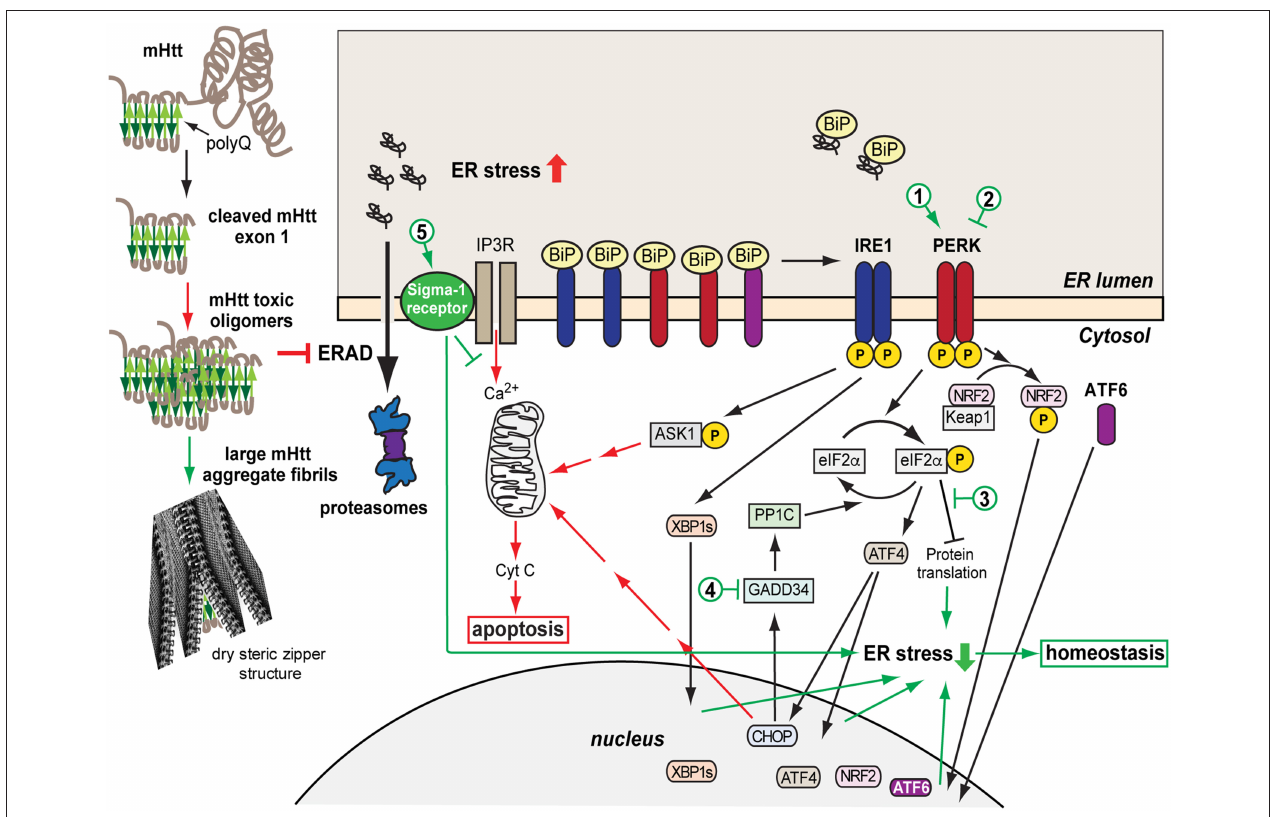
FIGURE 1 | Model of mHtt aggregation, generation of ER stress and the consequent UPR protective and later pro-apoptotic responses. A misfolded mHtt monomer, with the aggregation prone polyQ domain indicated (beta sheets in green) is cleaved and associates with other monomers to form toxic oligomers, which among other effects cause sequestration and depletion of ERAD factors such as p97, inhibiting ERAD. mHtt oligomers can associate into larger aggregate fibrils with dry steric zipper structure that shield the toxicity of mHtt. However, the transient presence of toxic mHtt oligomers, inhibiting ERAD, causes accumulation of unfolded secretory proteins and ER stress, activating the UPR sensors IRE1, PERK, and ATF6, starting an initial protective or adaptive phase of the UPR. This includes upregulation and translocation to the nucleus of transcription factors, XBP1s, ATF4, NRF2, ATF6, which induce expression of chaperones, ERAD machinery, anti-oxidative response components. Concurrently, eIF2 α phosphorylation by PERK causes transient arrest in translation, reducing the ER load. If the ER stress remains unresolved, the pro-apoptotic stage of the UPR is initiated, causing upregulation of ASK1-P and CHOP and Ca 2 + exit from the ER, inducing the intrinsic apoptotic pathway with the mitochondrial release of cytochrome C. Sigma-1 receptor is upregulated and modulates Ca 2 + release, with a protective effect. Cytotoxic pathways are indicated in red and cell protective ones in green. The numbers indicate possible points of therapeutic intervention, with activation (1) or inhibition (2) of PERK, inhibition of the downstream effects of eIF2 α -P (3), inhibition of eIF2 α -P dephosphorylation (4), and Sigma-1 receptor activation